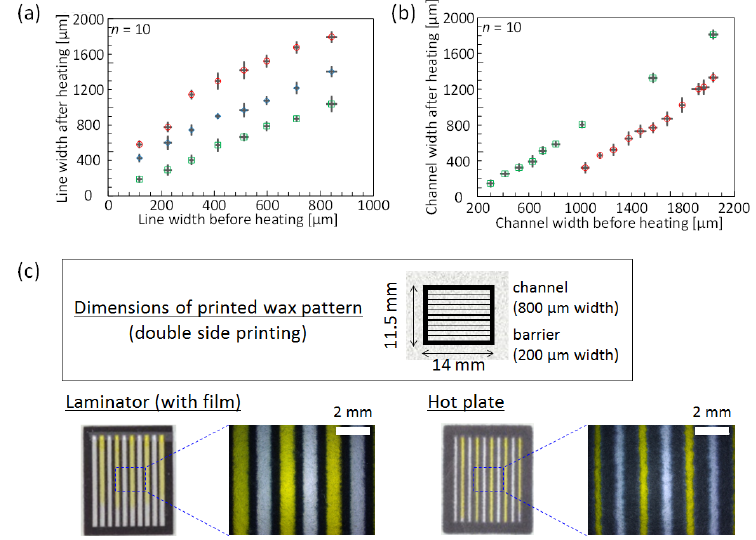
Figure 1. Comparison of resolution achieved for melting of printed wax into paper substrates by hot plate or hot lamination. ( a ) Wax line widths observed directly after printing and after heating with hot plate (red circles), hot laminator without top side lamination (blue diamonds), and hot laminator with full lamination (green squares) (mean value ± 1σ). ( b ) Microfluidic channel widths after heating by hot plate (red circles) or hot laminator with full lamination (green squares) (mean value ± 1σ). ( c ) Dimensions and photographs of 10 parallel microfluidic channels after lamination or hot plate (150 °C for 15 s) treatment. Channels visualized by application of colored aqueous solution.